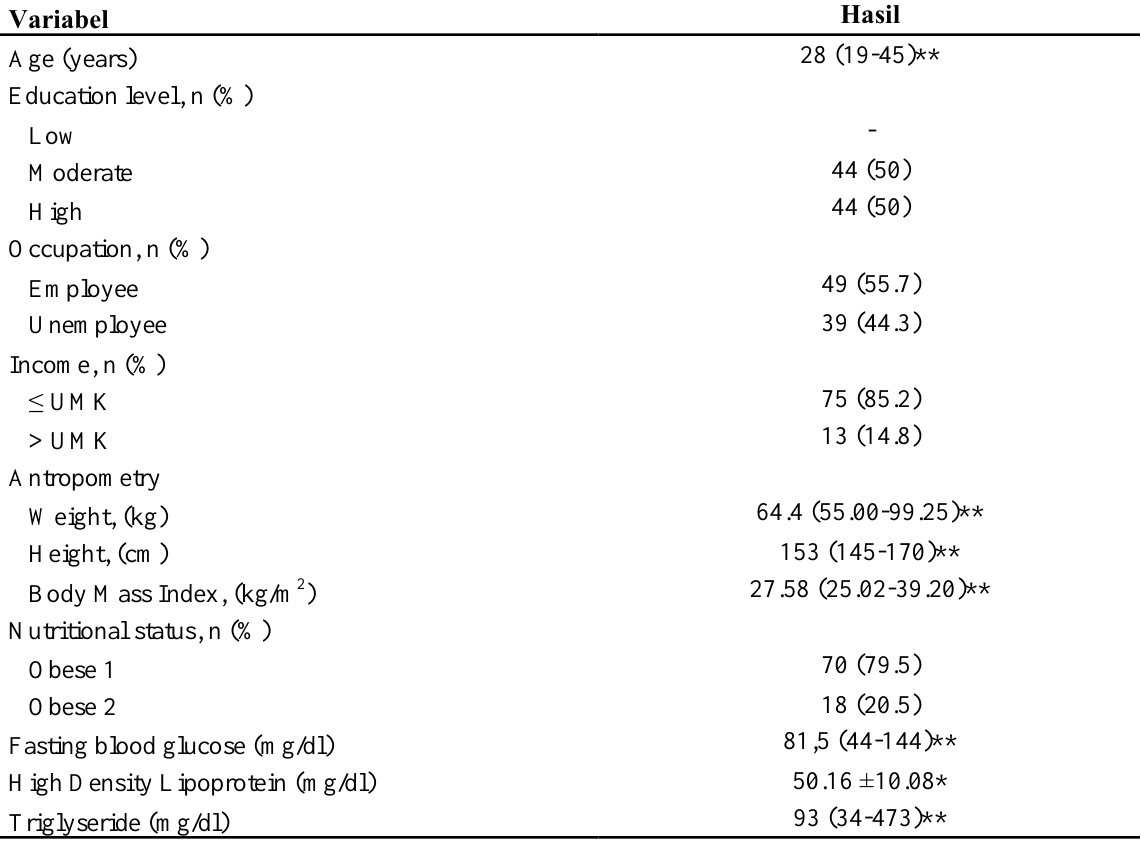
Table 1. Subjects’ characteristics